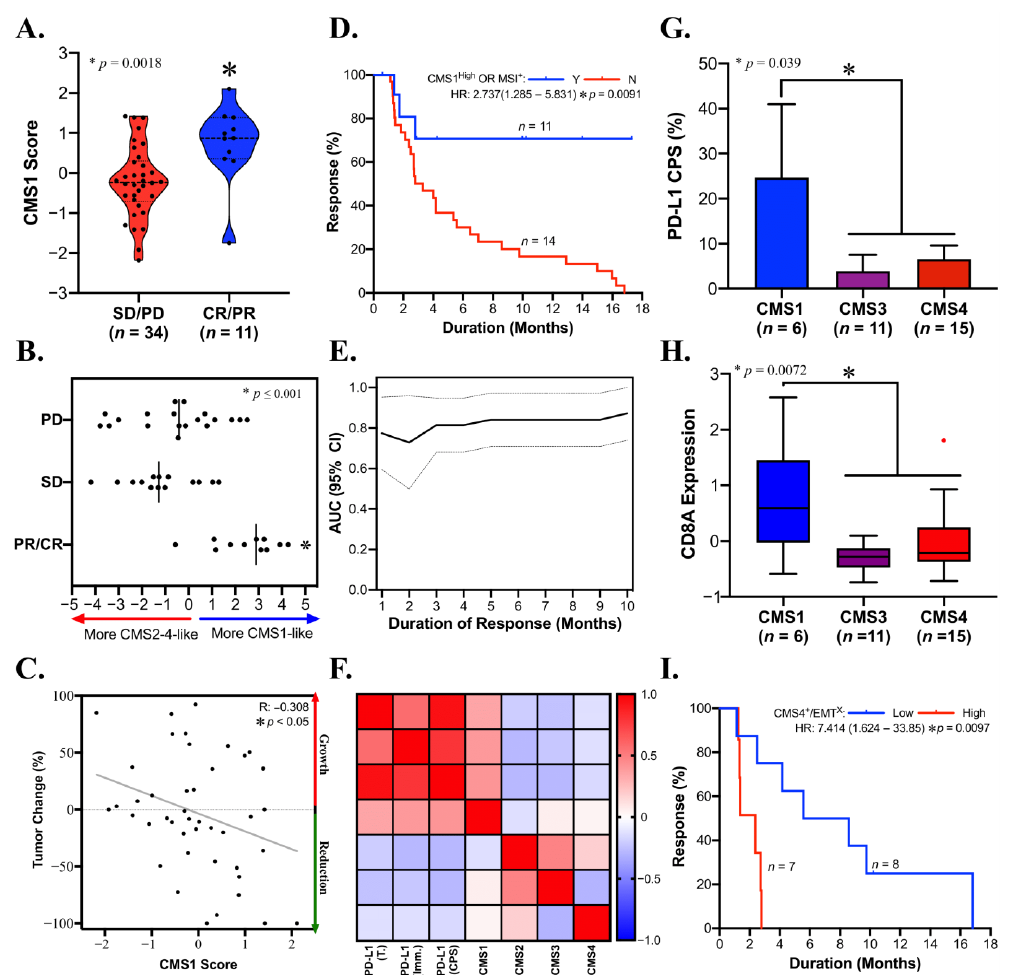
Figure 5. CMS1 predicts the response to subsequent lines of anti-PD1 (pembrolizumab) in advanced GAC. ( A ) CMS1 score is significantly increased in pembrolizumab responders in GAC ( p = 0.0018). ( B ) CMS1 High /CMS2-4 Low patients have improved responses to pembrolizumab ( p ≤ 0.001). ( C ) CMS1 score is linearly correlated with a reduction in tumor burden ( p < 0.05, R = − 0.308). ( D ) CMS1 combined with standard dMMR-based MSI status (n = 9 and n = 3 respec- tively) predicts sustained durability of pembrolizumab therapy. ( E ) ROC analysis from 1–14 months post treatment shows that the CMS1 score is sensitive and specific for prediction of pembrolizumab response at 9, 10, and 13 months post treatment (AUC: 0.7179–0.7833, p < 0.05). ( F ) Correlation matrix demonstrating that the CMS1 score is positively correlated with PD-L1 immunohistochem- istry scoring, whereas CMS2-4 scores are not. ( G ). PD-L1 CPS is significantly upregulated in CMS4 classified as advanced GACs compared to CMS3/4 ( p = 0.0309). ( H ) The cytotoxic T-cell marker CD8A is significantly upregulated in CMS1 classified as advanced GACs compared to CMS3/4 ( p = 0.0072). ( I ). CMS4/EMT Low tumors demonstrated a significantly longer duration of response to pembrolizumab compared to CMS4/EMT High tumors (median PFS: 7.079 and 2.378 months, respectively; p =